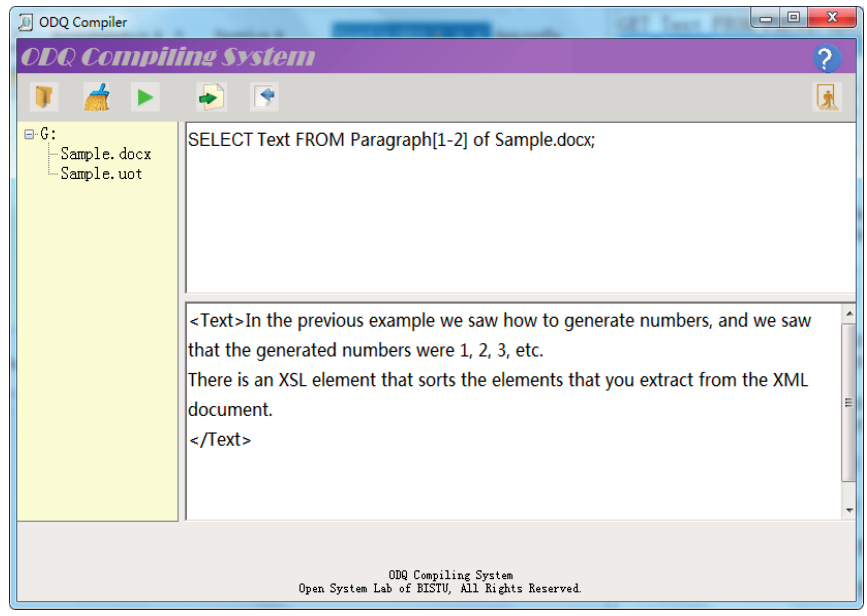
Figure 4. Fetch text content from the first two paragraphs from an OOXML